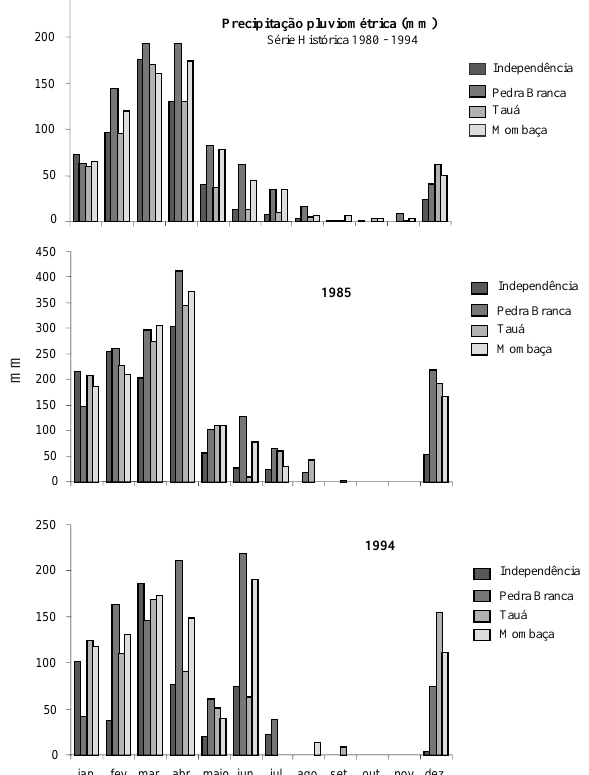
Figura 3. Precipitação pluviométrica nos municípios de Independência, Pedra Branca, Tauá e Mombaça